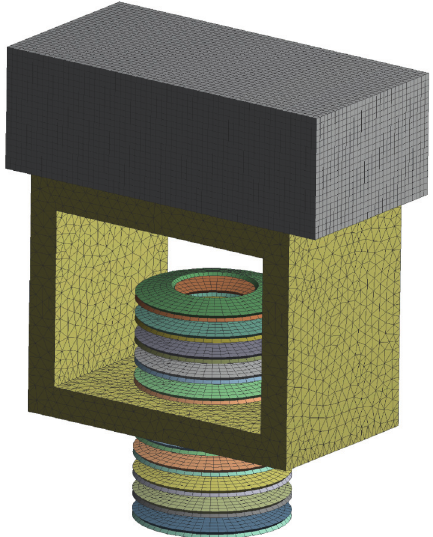
Figure 4: Simulation model of the disc spring